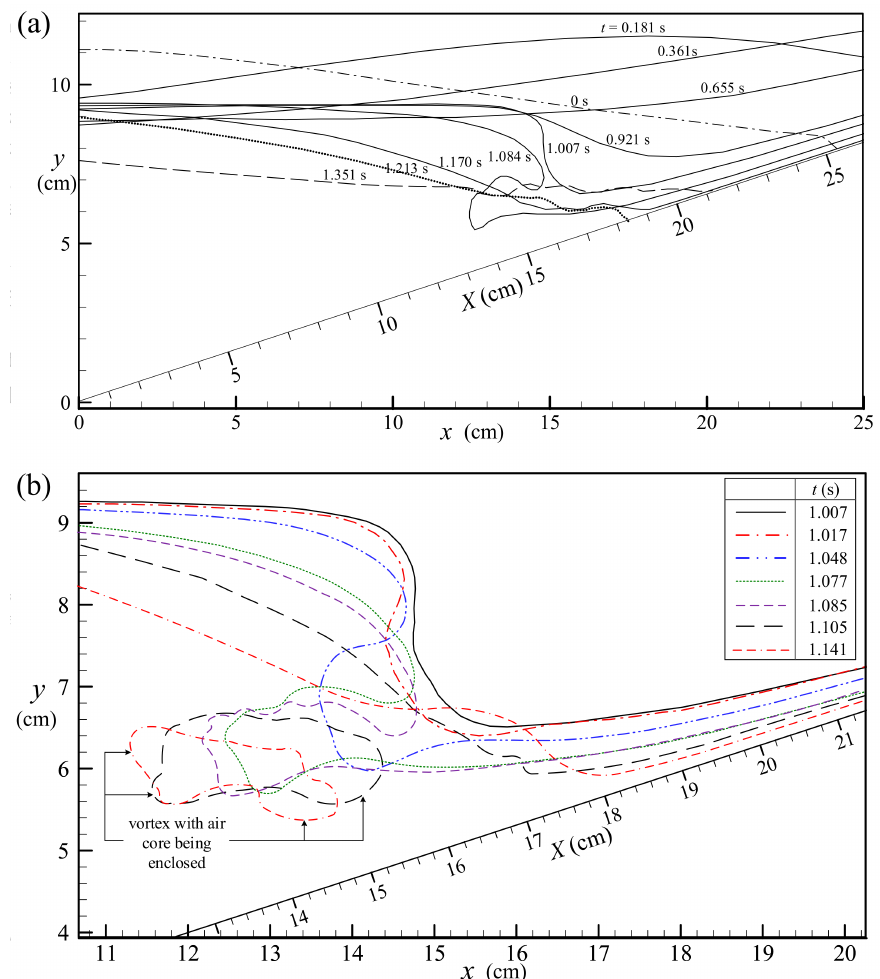
Figure 5. Temporal and spatial variations of free surface profile: ( a ) global view for 0 s ≤ t ≤ 1.351 s (0 ≤ T ≤ 14.96); and ( b ) magnified view for run-down process during time interval 1.007 s ≤ t ≤ 1.141 s (11.15 ≤ T ≤ 12.64) (Case